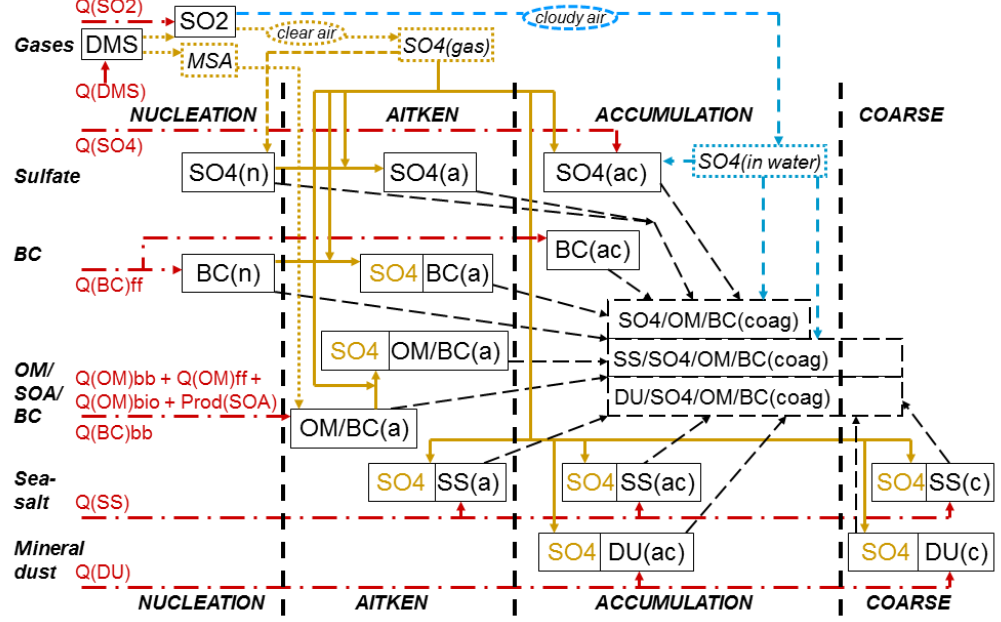
Fig. 1. Schematic for aerosol particle processing in CAM4-Oslo. The source terms on the left side, labeled Q(X)y, where X is the constituent name and y is the source type, may come from primary emission or secondary production. The source labels bb, ff and bio respectively indicate biomass burning, fossil fuel combustion, and biogenic sources. Primary particles are emitted (dashed-dotted arrows) as accumulation- mode sulphate (SO4(ac)), nucleation and accumulation mode black carbon (BC(n), BC(ac)), Aitken mode BC (BC(a)), internally mixed Aitken mode organic matter and BC (OM/BC(a)), Aitken, accumulation, and coarse mode sea salt (SS(a), SS(ac), SS(c)), accumulation and coarse mode mineral dust (DU(ac), DU(c)). Model calculated gas-phase components are DMS and SO 2 . Gaseous sulphate (SO4(gas)) produced in air is assumed to be transformed to nucleation-mode sulphate (SO4(n), dotted arrow) if insufficient particle surface area is available for condensation (solid arrows). Sulphate produced by in cloud water droplets (SO4(in water), short-dashed arrow) is partly added to SO4(ac) but mainly to a broad internal mixture of accumulation and coarse mode particles (of which there are two types with respect to complexity). Long-dashed arrows represent coagulation which contributes to the latter particle